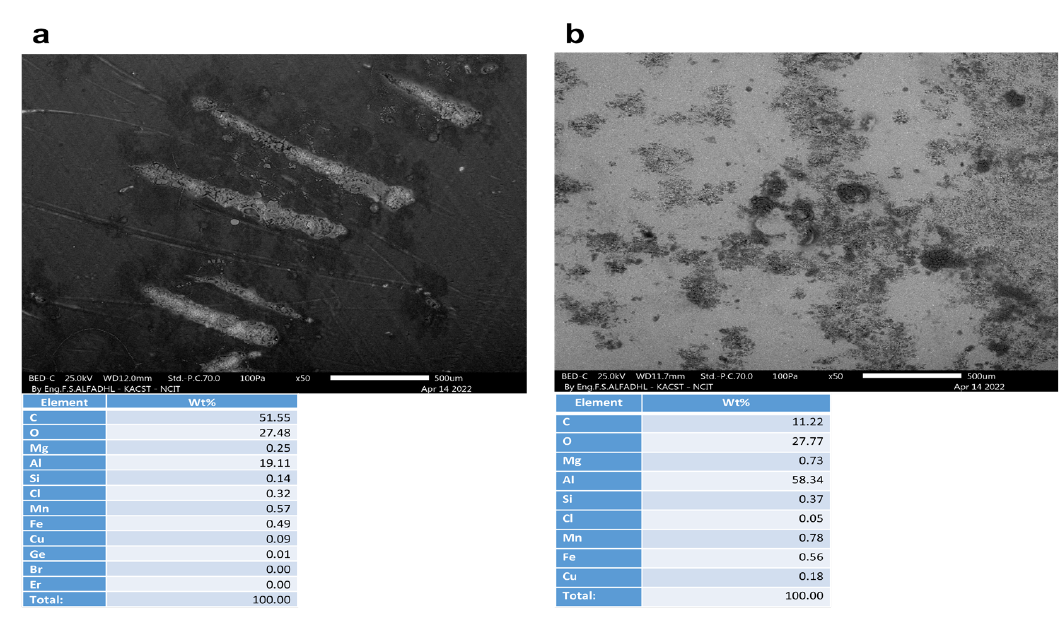
Figure 11. SEM and EDS analysis of Green Cola samples after corrosion tests under different conditions: ( a ) in acetic acid in the presence of an organic coating (WC) and ( b ) without an organic coating (WOC).